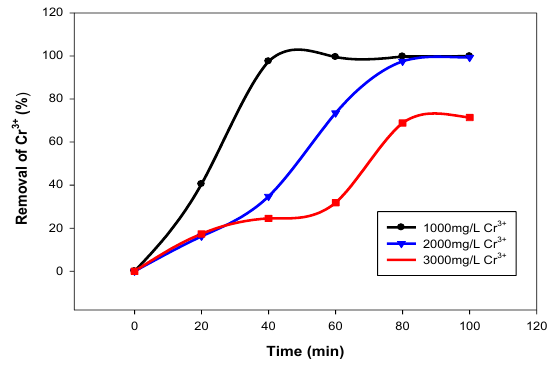
Fig. 3. Variation of extent of Cr 3+ removal with time for different initial Cr 3+ concentrations. Inter electrode dis- tance: 3cm, current density: 9.34mA/cm 2 , supportive electrolyte 1000 mg/L NaCl.